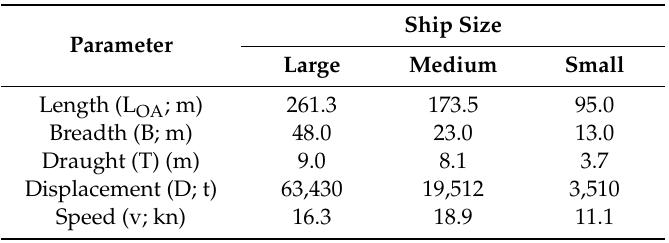
Table 1. The technical and operational parameters of ships used in the tests.